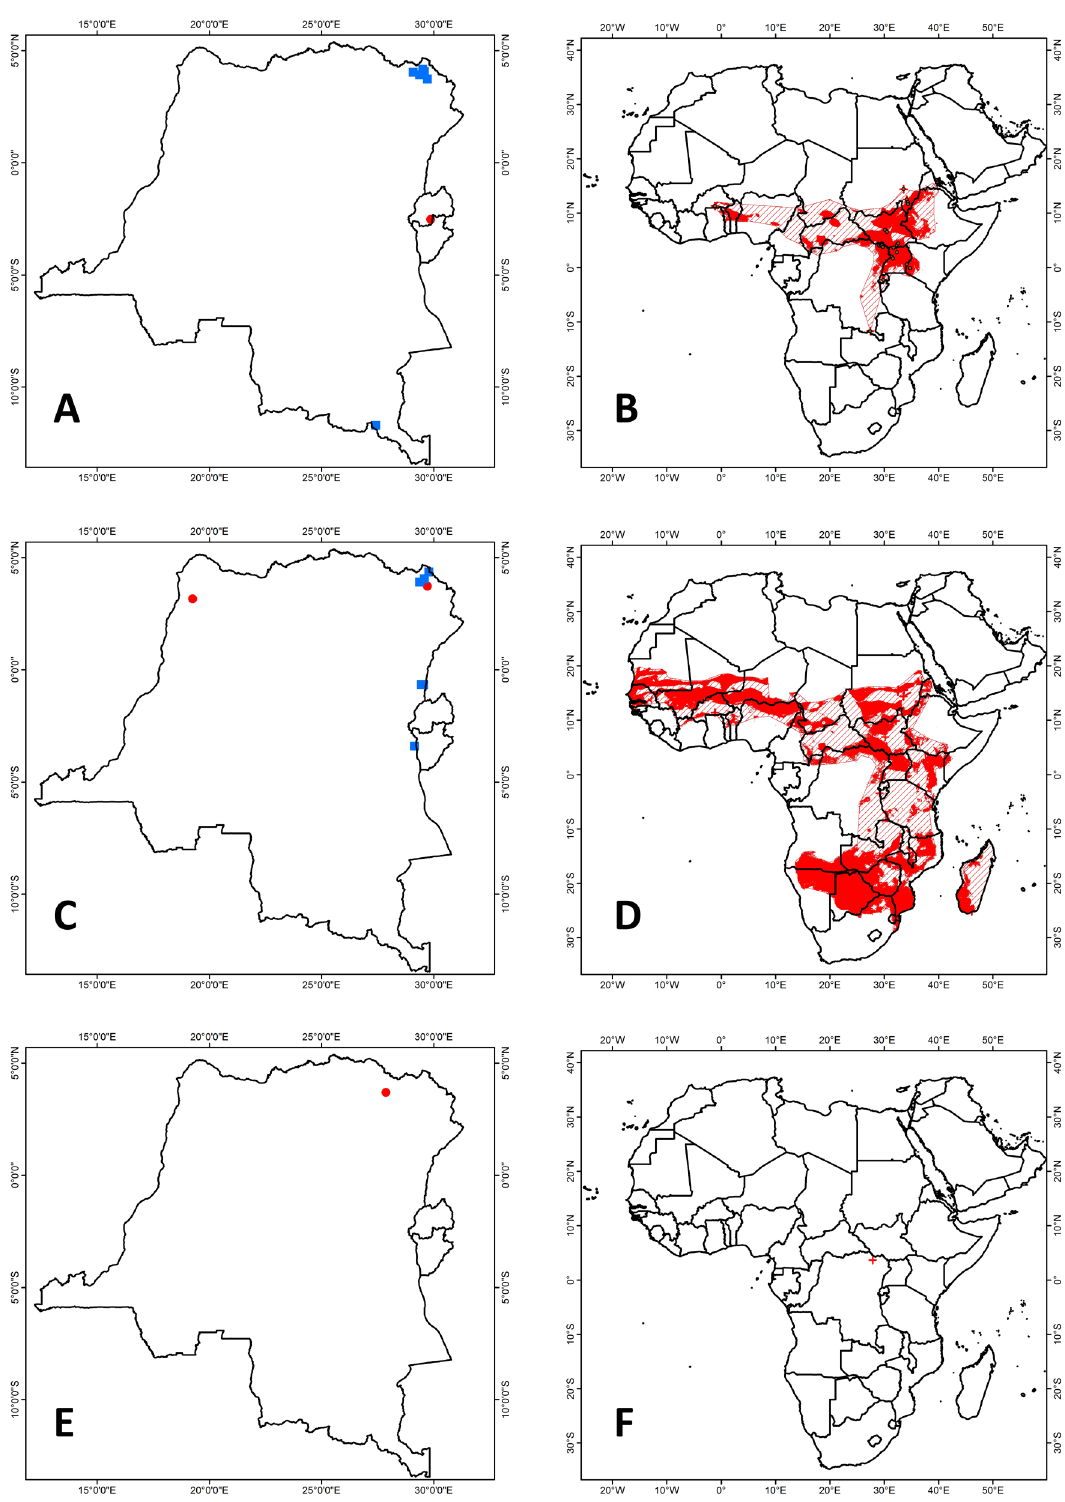
Fig. 28. Distribution maps. A–B . Mops (Mops) demonstrator (Thomas, 1903). C–D . Mops (Mops) midas (Sundevall, 1843). E–F . Mops (Mops) niangarae J.A. Allen, 1917. A, C, E. Distribution in